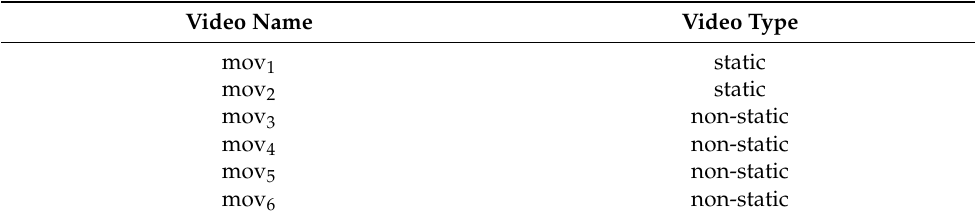
Table 2. Types of six video recordings employed for ENF